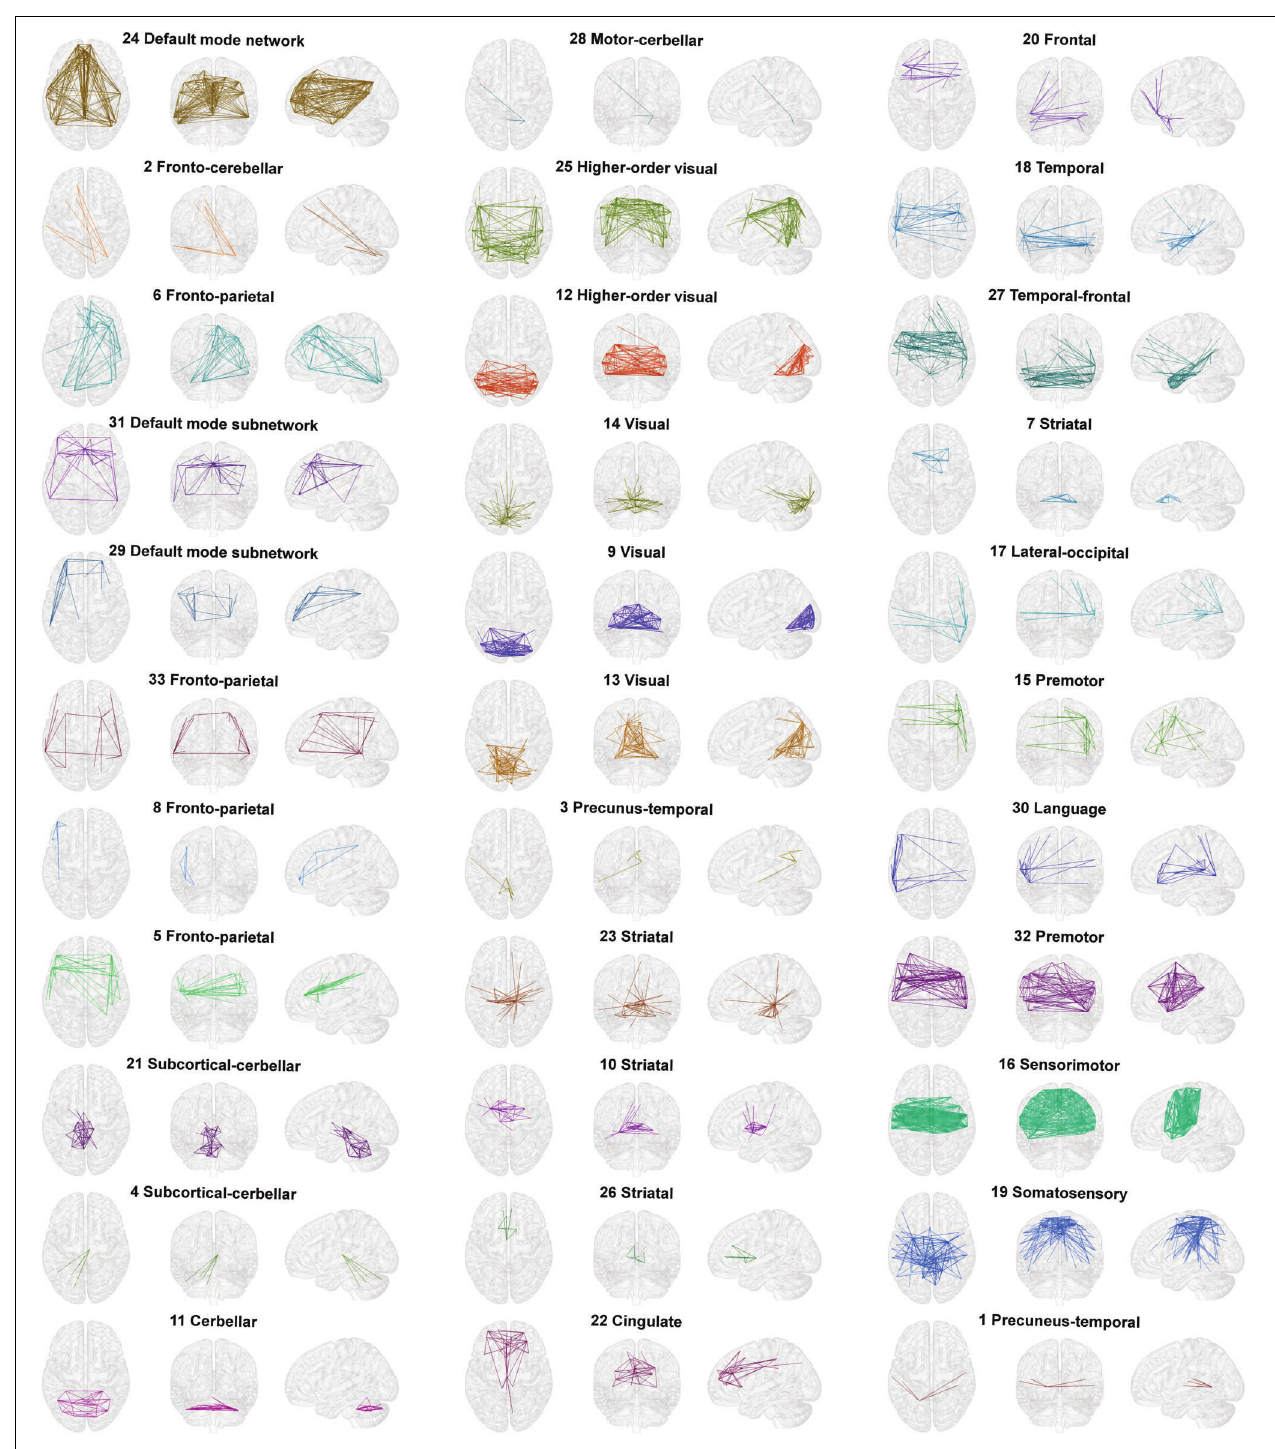
FIGURE 3 | Connectivity networks. All 33 connectivity networks found in the hierarchical cluster analysis of time and group averaged connectivity. Networks can also be inspected interactively and in three dimensions online (http://openscience.cbs.mpg.de/schaefer).